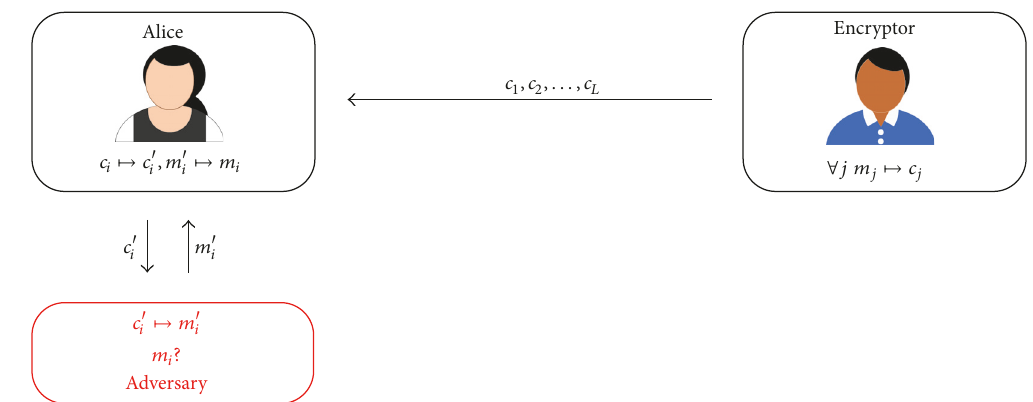
Figure 5: Malicious decryptor. The adversary attempts to learn the plain-text message that Alice